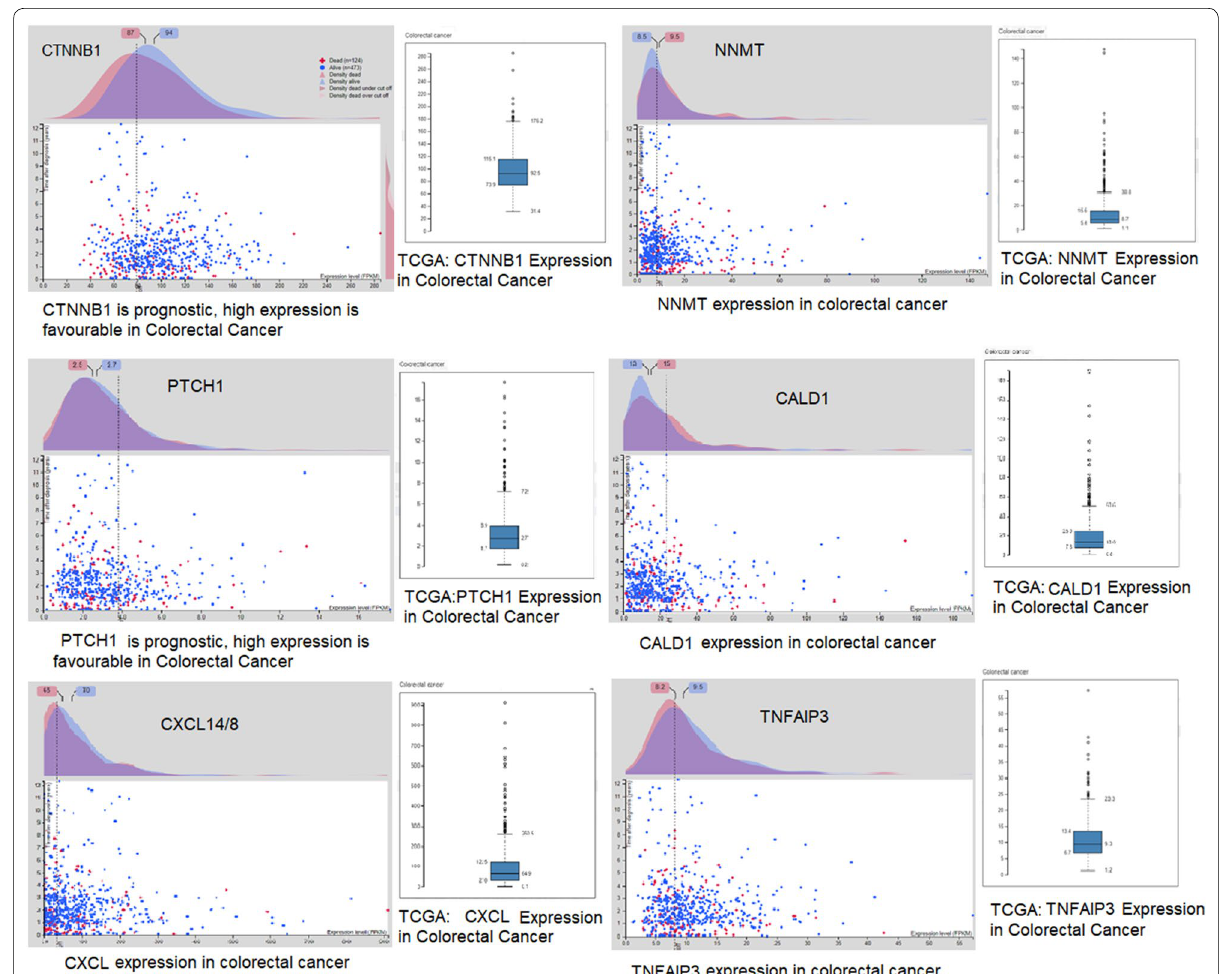
Fig. 7 Interactive scatter plot indicates the expression-level of differentially expressed genes in colorectal cancer. These plots showed the consequence of RNA and protein levels on clinical